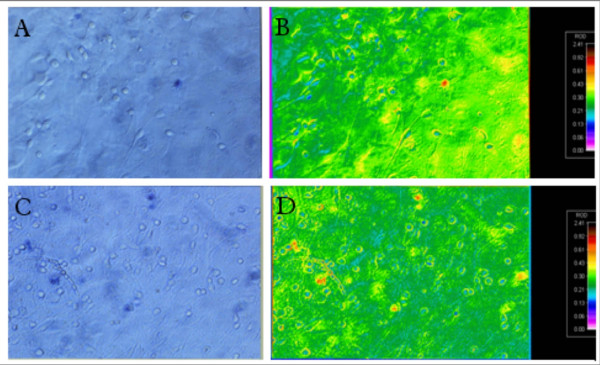
True and false color photomicrographs of human neurons (A-C). Control culture after trypan blue exclusion assay in true color (A) and false color (B). Cultures exposed to HIV proteins 40 nM Tat plus 32.5 pM gp120 and 1.6 μM cocaine show synergistic toxicity trypan blue exclusion assay in true color (C) and false color (D).